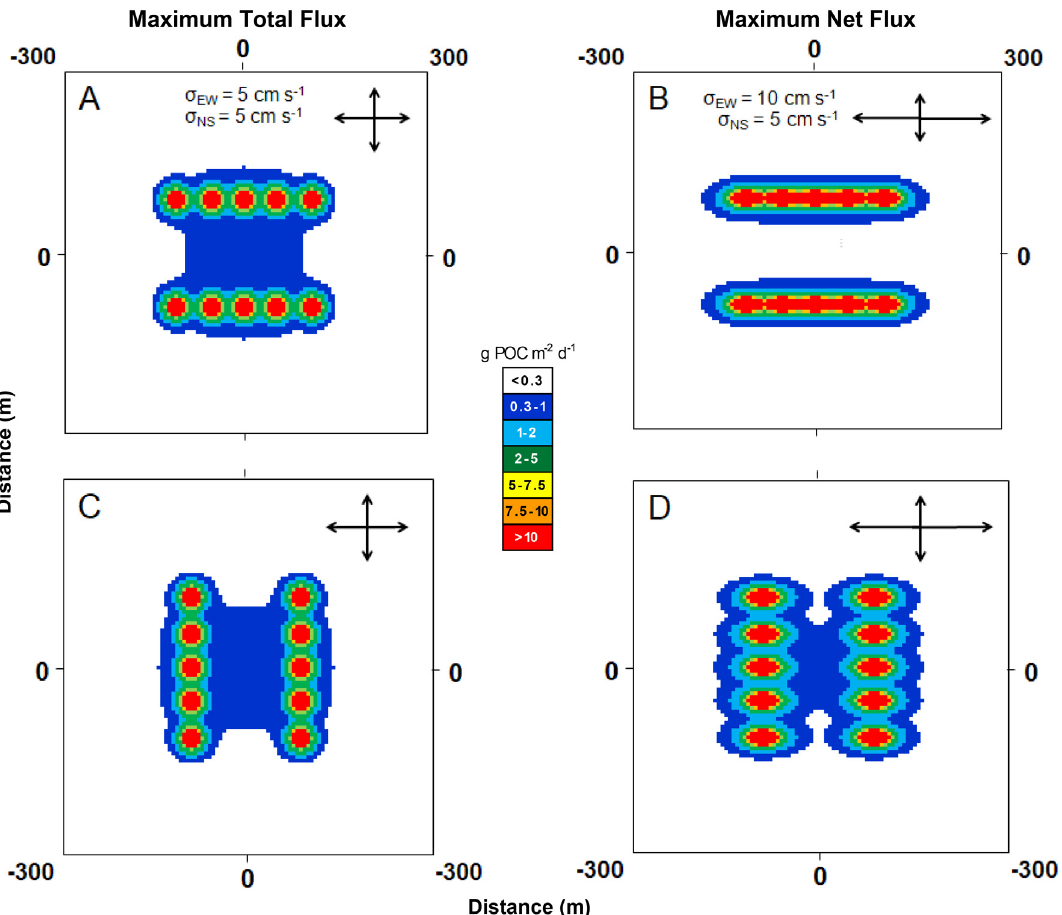
Fig. 9. Model output for depositional areas and maximum total and net POC flux with changes in net-pen array orientation to the predominant current direction. Model variables as in Fig. 7C (under net-pen depth: 8.4 m; 3 fecal size classes) but mean currents ( μ EW and μ NS ) = 0. (A,B) Long axis of the net-pen array parallel to the predominant EW current, (C,D) perpendicular orientation. (A,C) Equal standard deviations for directional currents ( σ EW and σ NS ), (B,D) σ EW increased ×2. Arrows illustrate the relative magnitude of current standard